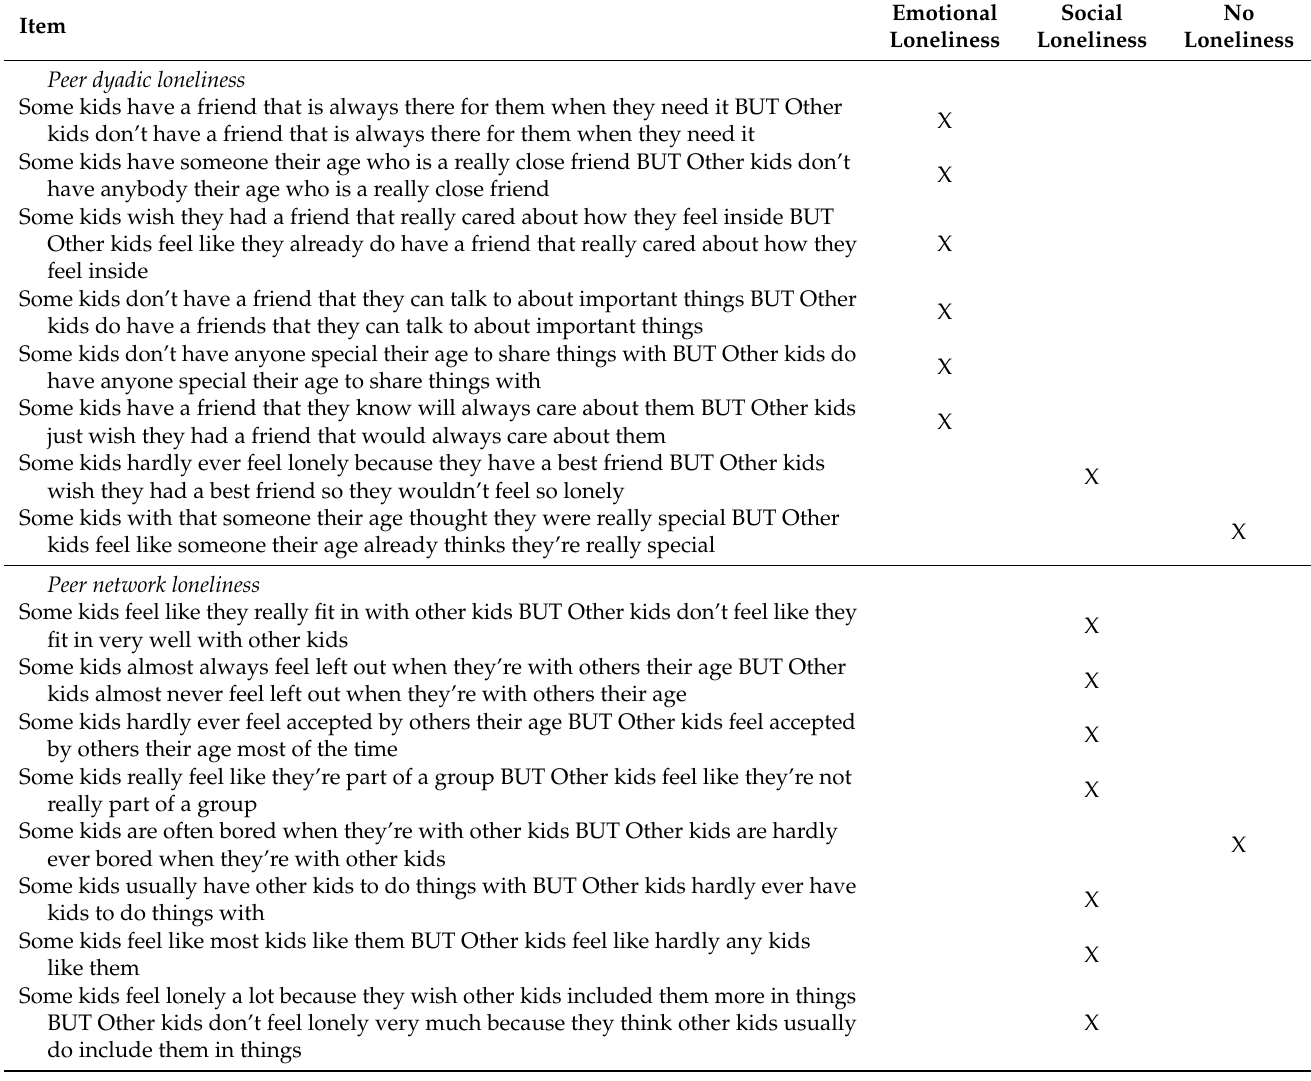
Table 8. Coding of Items of the Peer Network and Dyadic Loneliness Scale